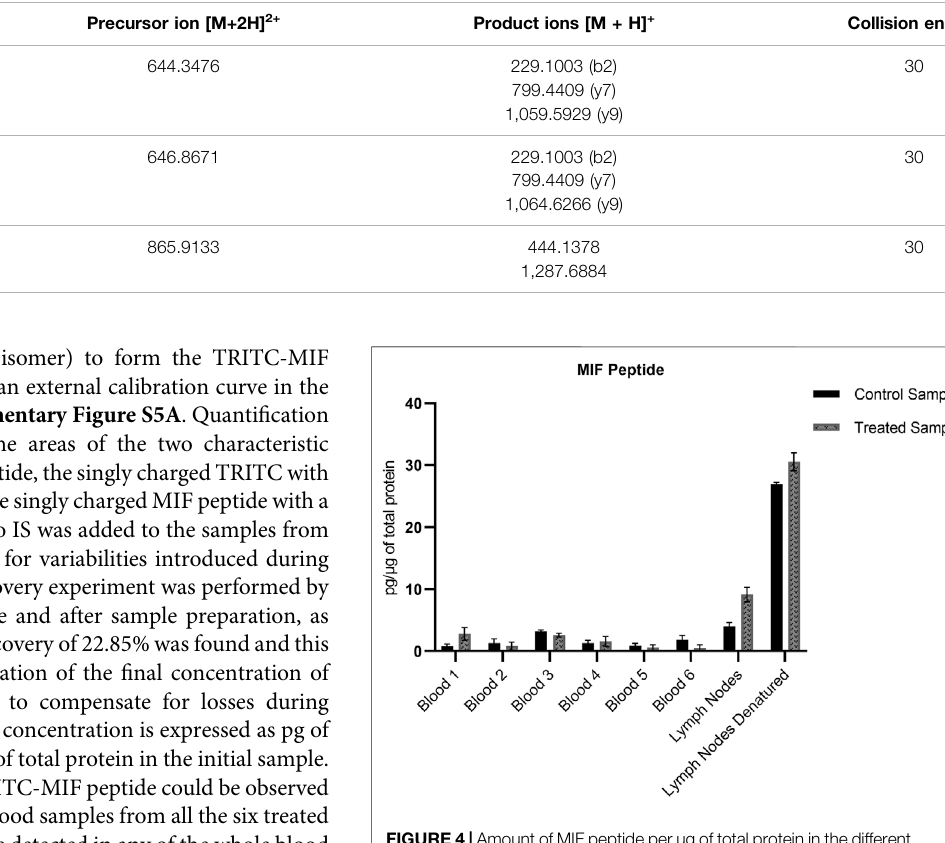
FIGURE 4 | Amount of MIF peptide per µg of total protein in the different whole blood and lymph node samples. No signi fi cant difference ( p < 0.05) could be observed for the MIF peptide between the treated and control samples. Values are the mean of three replicate analysis ±